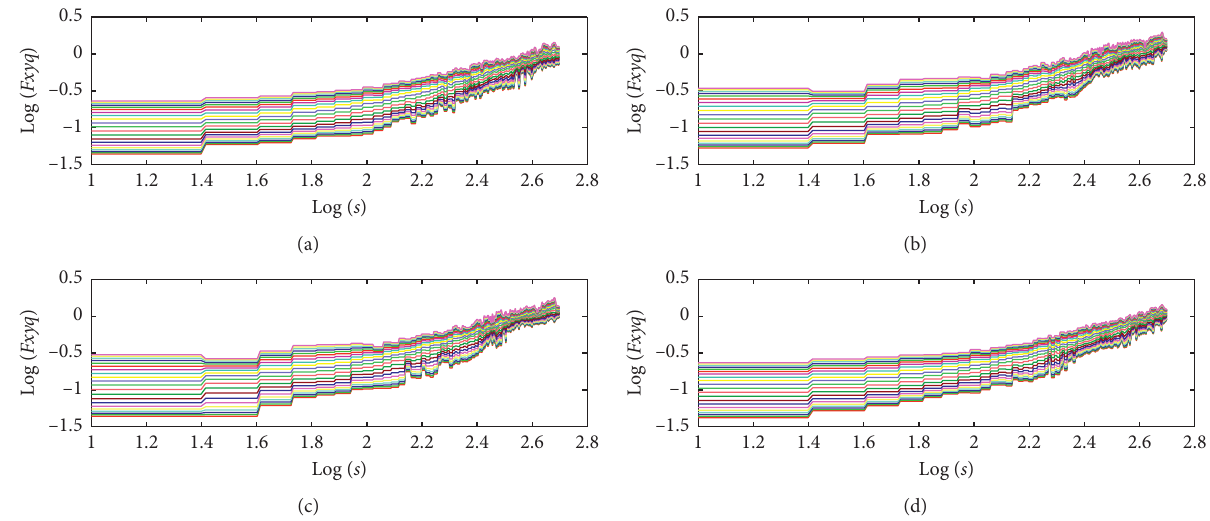
Figure 6: Log-log plots of cross-correlation fluctuation function versus time scale s for market participation willingness and Chinese stock market volume. (a) SME. (b) SSE50. (c) CSI300. (d) GEM.